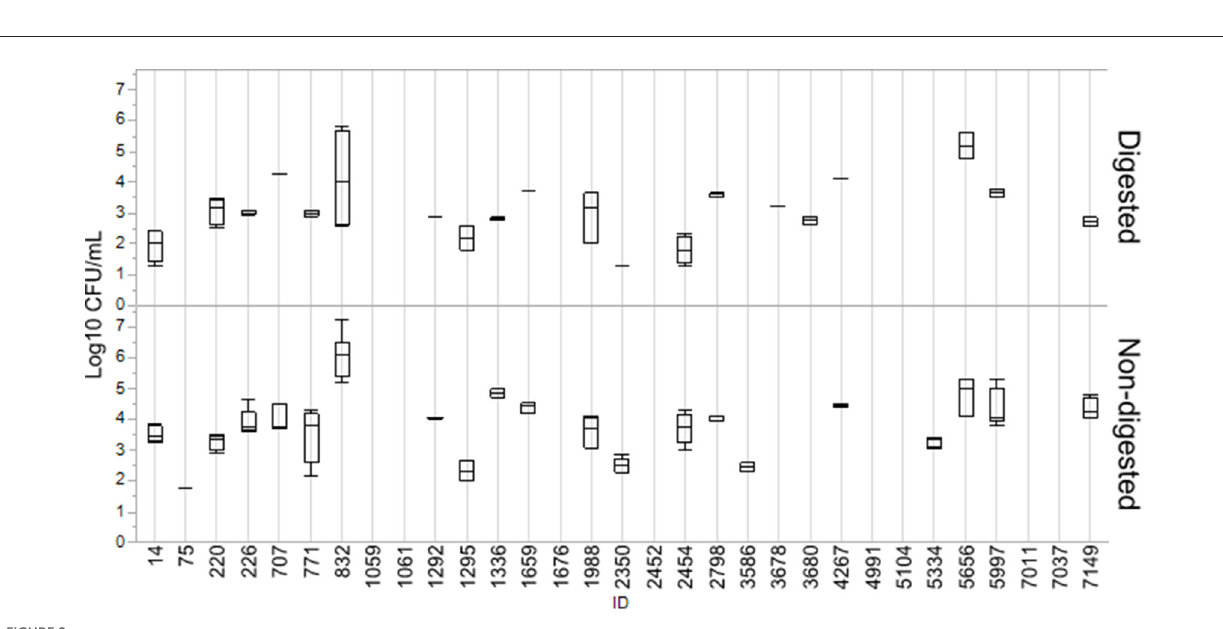
FIGURE2 Log10 CFU/ml of transconjugants for digested and non-digested isolates. Boxes represent the quartiles and the median value, with included confidence intervals as the standard error of mean indicated by whiskers. Values are given in the number of Log10 CFU/ml. No whiskers are visible for isolates where the outer quartile is equal to the minimum or maximum value. For isolates where no transfer was detected, no box is